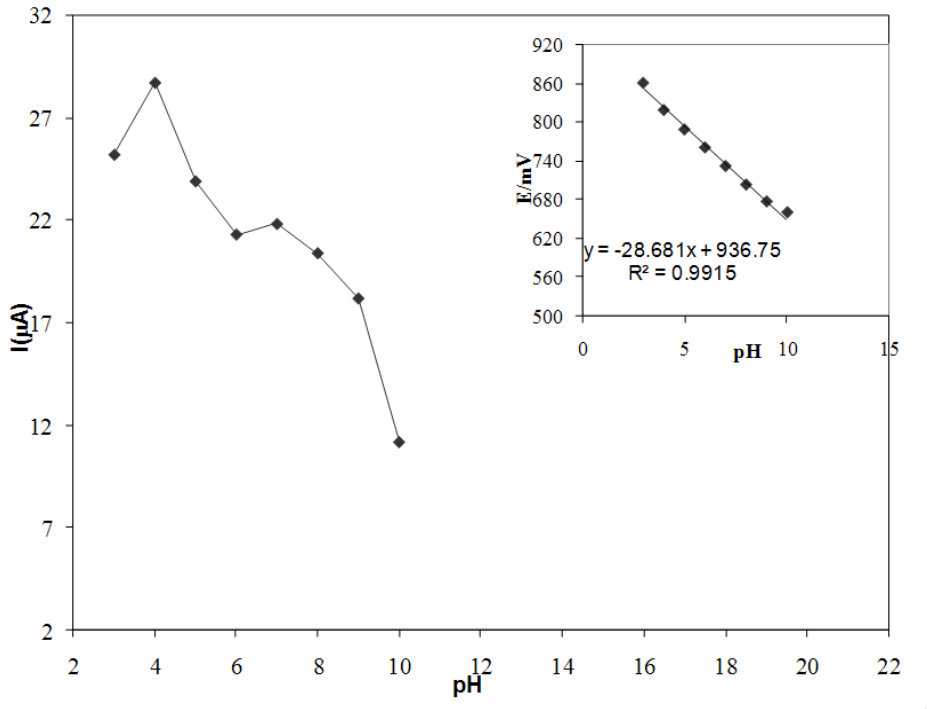
Figure 5. Influence of pH on the (a) peak current and (b)peak potential for 5.0 × 10 − 7 M in acetate